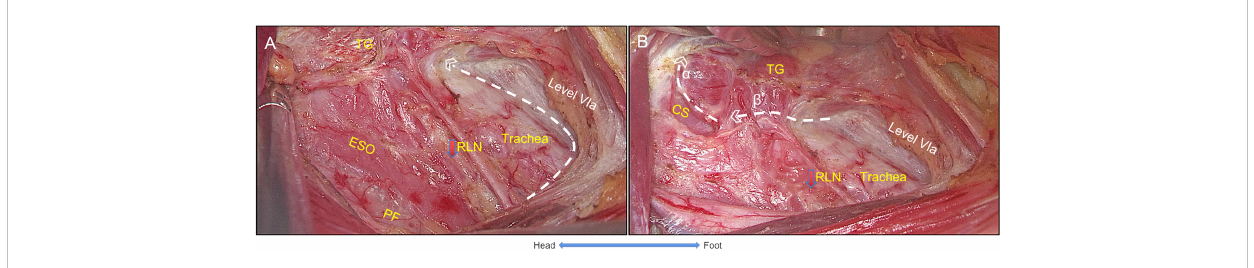
FIGURE 4 The settlement of RLN. (A) While the RLN was traced, the pretracheal space was expanded to reveal level VIa. (B) Line a shows that the superior vessels of the thyroid gland were ligated by exposing the cricothyroid space while the superior parathyroid gland was preserved, and Line b shows that the thyroid gland was resected with the entering point of RLN exposed and the RLN freed from the thyroid gland. Thus, the settlement of RLN was completed. TG, thyroid gland; RLN, recurrent laryngeal nerve; ESO, esophagus; PF, prevertebral fascia; CS, cricothyroid space. White lines with angle represent cutting lines.